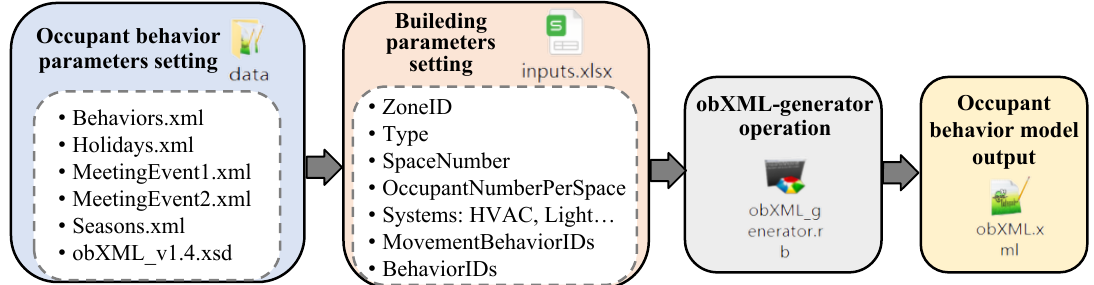
Figure 6. A guide to the use of obXML-generator.